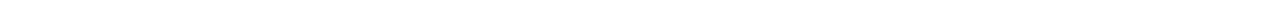
Fig. 3 Late recombination markers in wild type and Atr S/S spermatocytes. a Left panels, representative images of late pachytene spermatocytes immunostained against SYCP3 and RNF212. Scale bar = 10 μ m and applies to both images. Right panel, quanti fi cation of RNF212 foci. Horizontal black lines denote the means; the p value is from t test, and comparisons without p values stated were not signi fi cant ( p > 0.05). b Left panels, representative images of pachytene spermatocytes immunostained against SYCP3 and MLH1. Scale bar = 10 μ m and applies to both images. A bivalent lacking an MLH1 focus in the Atr S/S spermatocyte (white box) is magni fi ed in the inset. Right panel, quanti fi cation of autosomal MLH1 foci at pachynema. Horizontal black lines denote the means. Atr S/S and control were compared by Mann – Whitney test. c Proportion of bivalents without an MLH1 focus. N = 1520 (mutant) or 1653 (control); p value is from Fisher ’ s exact test. d Left, representative images of diplotene spermatocytes immunostained against SYCP3. Scale bar = 10 μ m. Achiasmate bivalents (white boxes) are magni fi ed in the insets. Right, percentage of achiasmate bivalents at late diplonema from Atr + / + ( N = 798) and Atr S/S ( N = 912) spermatocytes ( p = 0.84, Fisher ’ s exact test). e Cumulative frequency plots comparing MLH1 focus distribution along autosomal